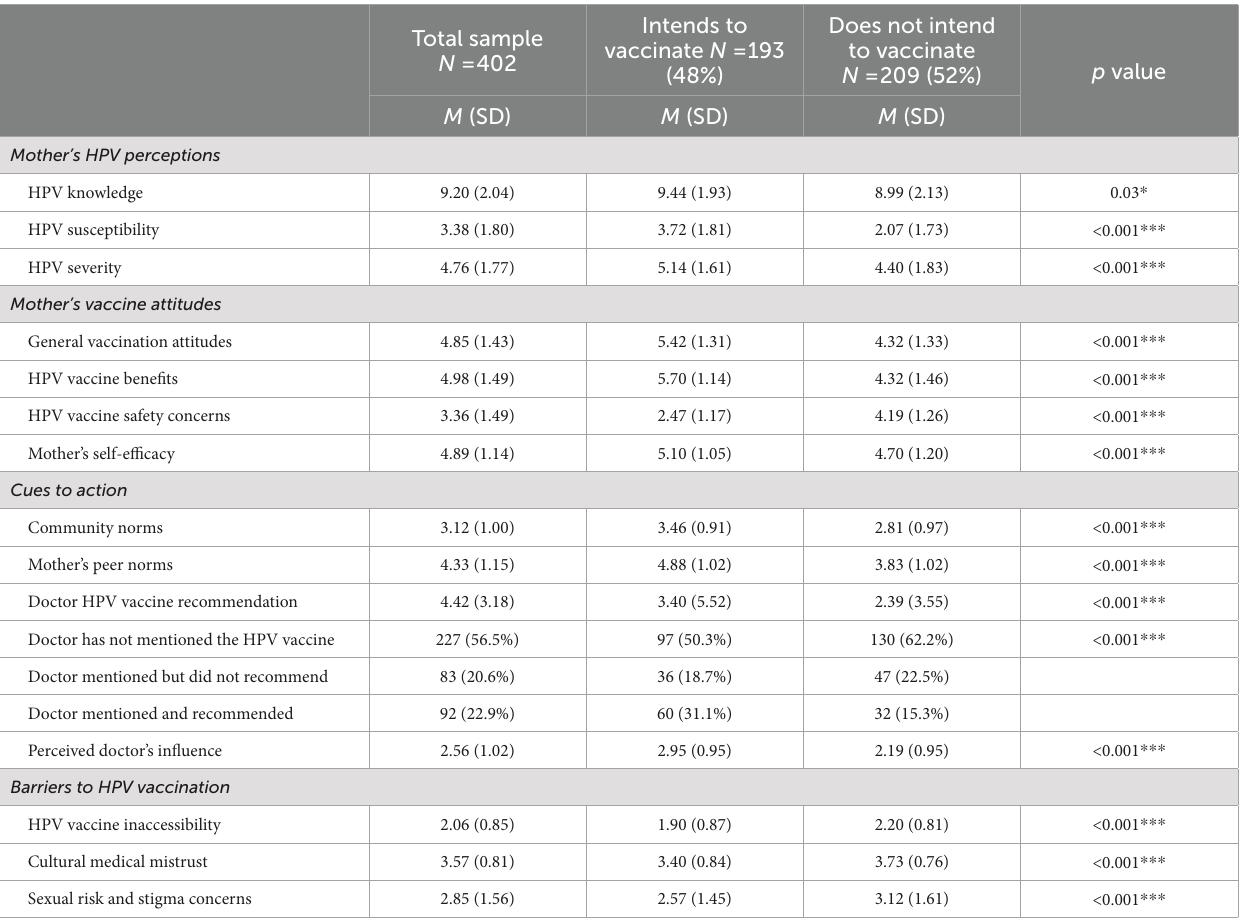
Statistical tests: Independent t -tests for all means and chi-square tests of independence assessed percentage endorsement of doctors mentioning/recommending the HPV vaccine. HPV knowledge was scored out of a total of 13